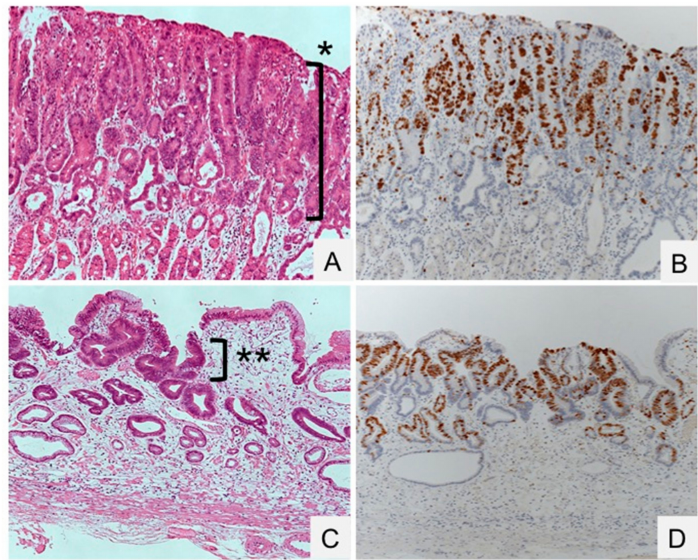
Figure 2. Gastric dysplasia (intramucosal adenocarcinoma) before and after eradication of Helicobacter pylori . ( A , B ) Dysplasia proliferating to the surface of the mucosa in an H. pylori -positive specimen (*). ( C , D ) Regression of dysplasia, localized beneath the normal surface epithelium in an H. pylori -negative specimen (**). HE staining ( A , B ) and Ki-67 immunostaining ( C , D ). Original magnification, 100 ×